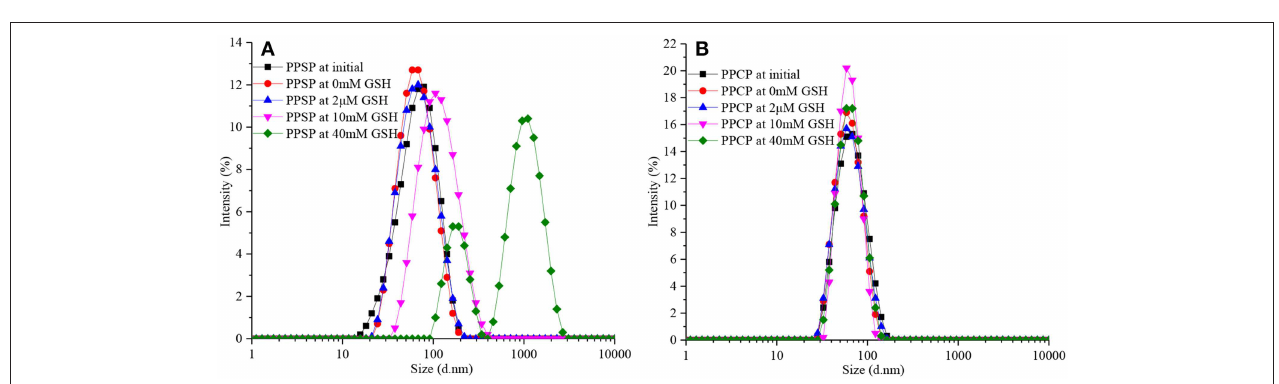
FIGURE 5 | Particle sizes change of PPSP (A) and PPCP (B) micelles at different GSH concentrations.